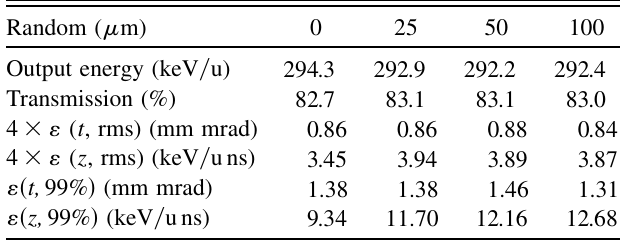
TABLE X. Effect of random vane modulation error with in- creasing